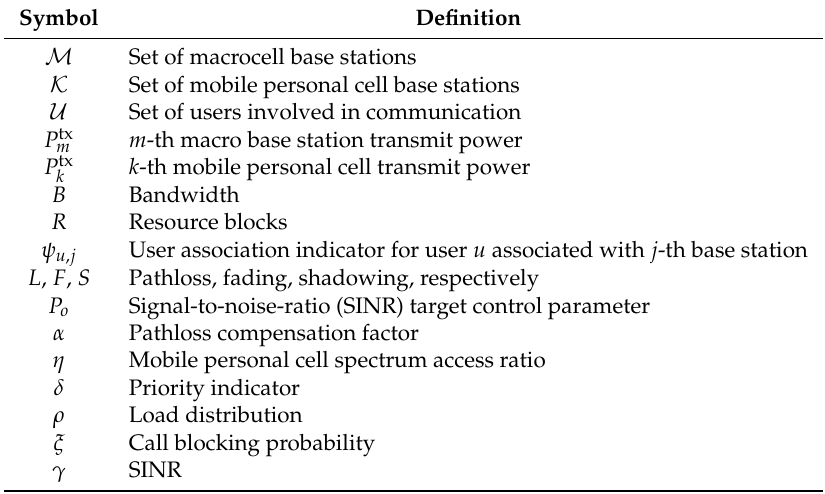
Table 1. Table of symbols for PS-CARA